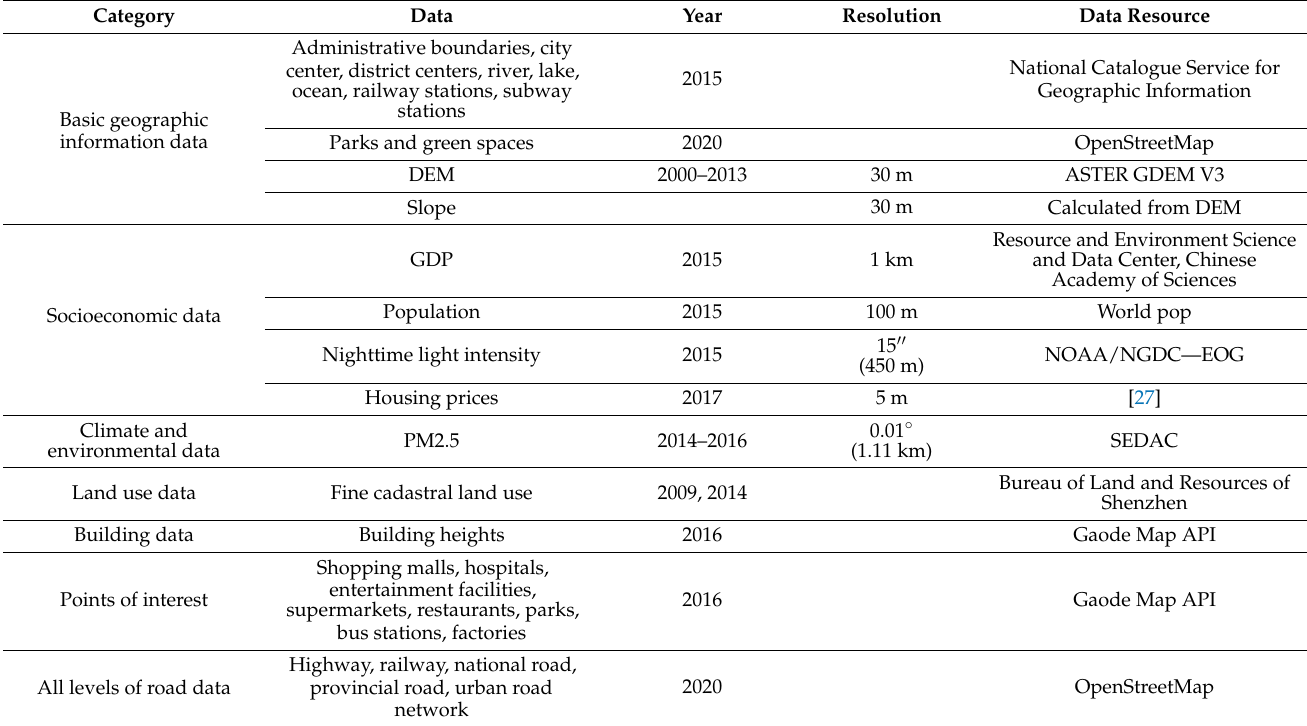
Table 1. List of data used in this study.